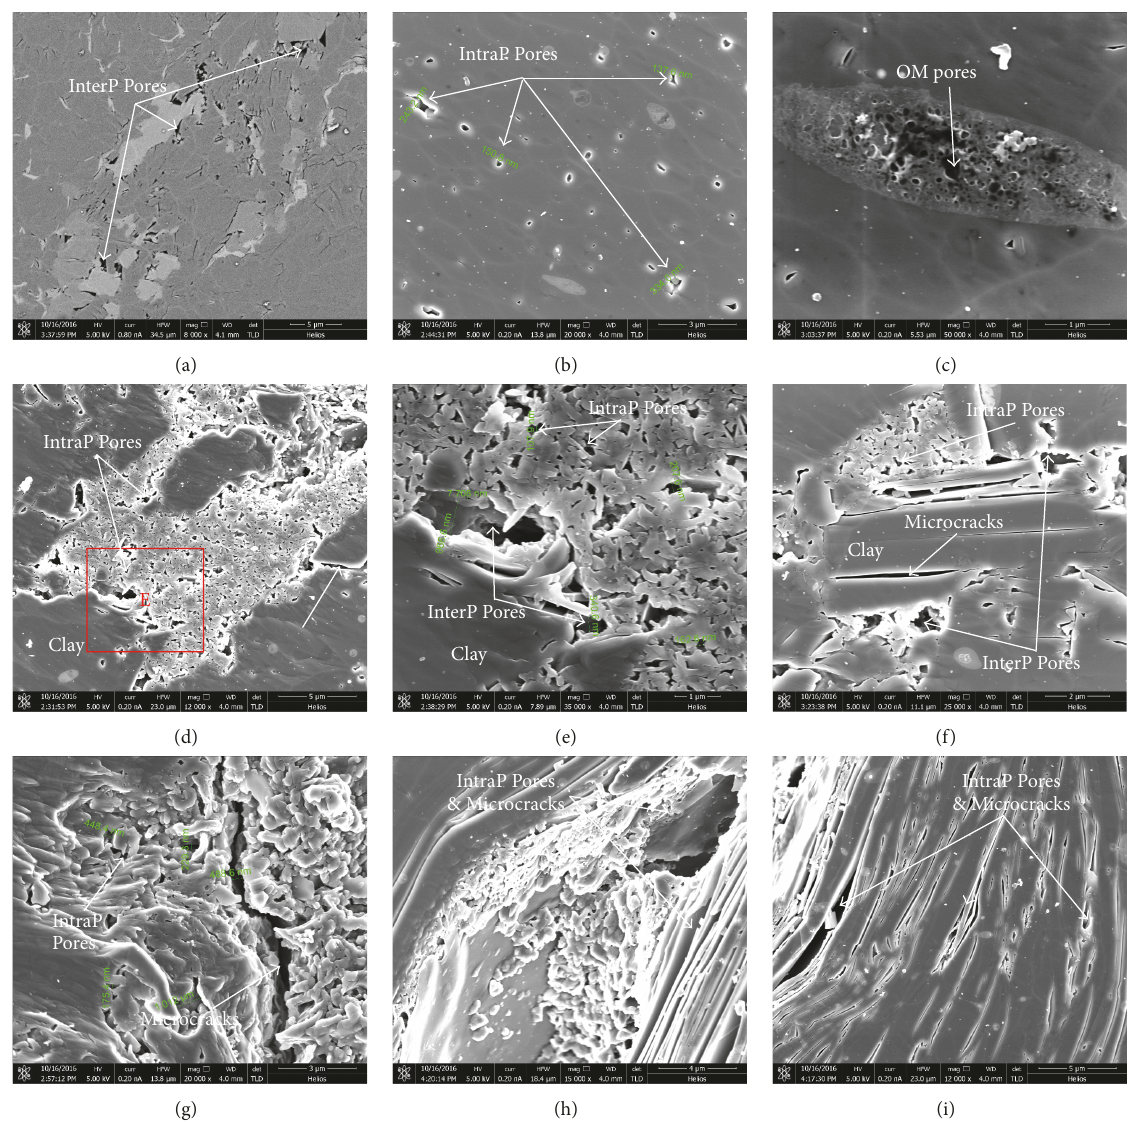
Figure 3: The FIB-SEM images of sample JH-S ( 𝜑